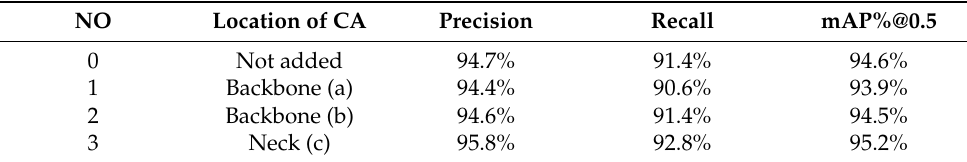
Table 1. Ablation experiment of Coordinate Attention.